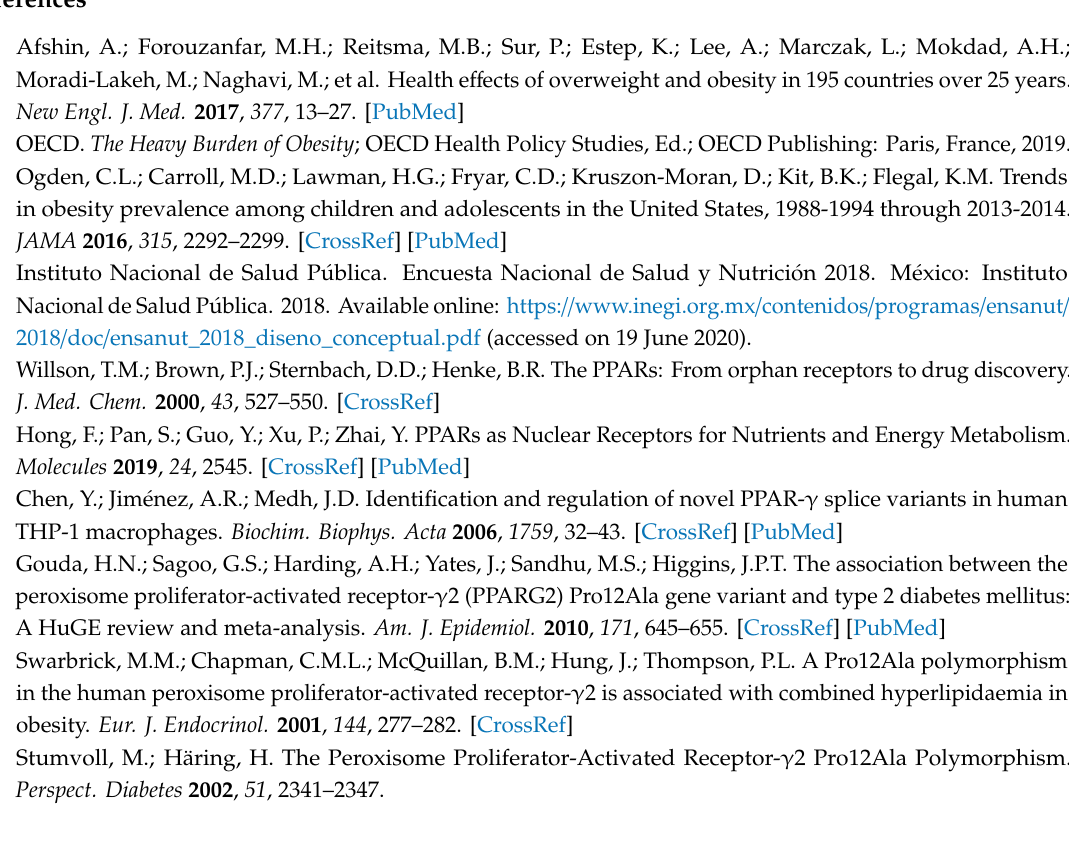
Figure S1: Electrophoresis example for both